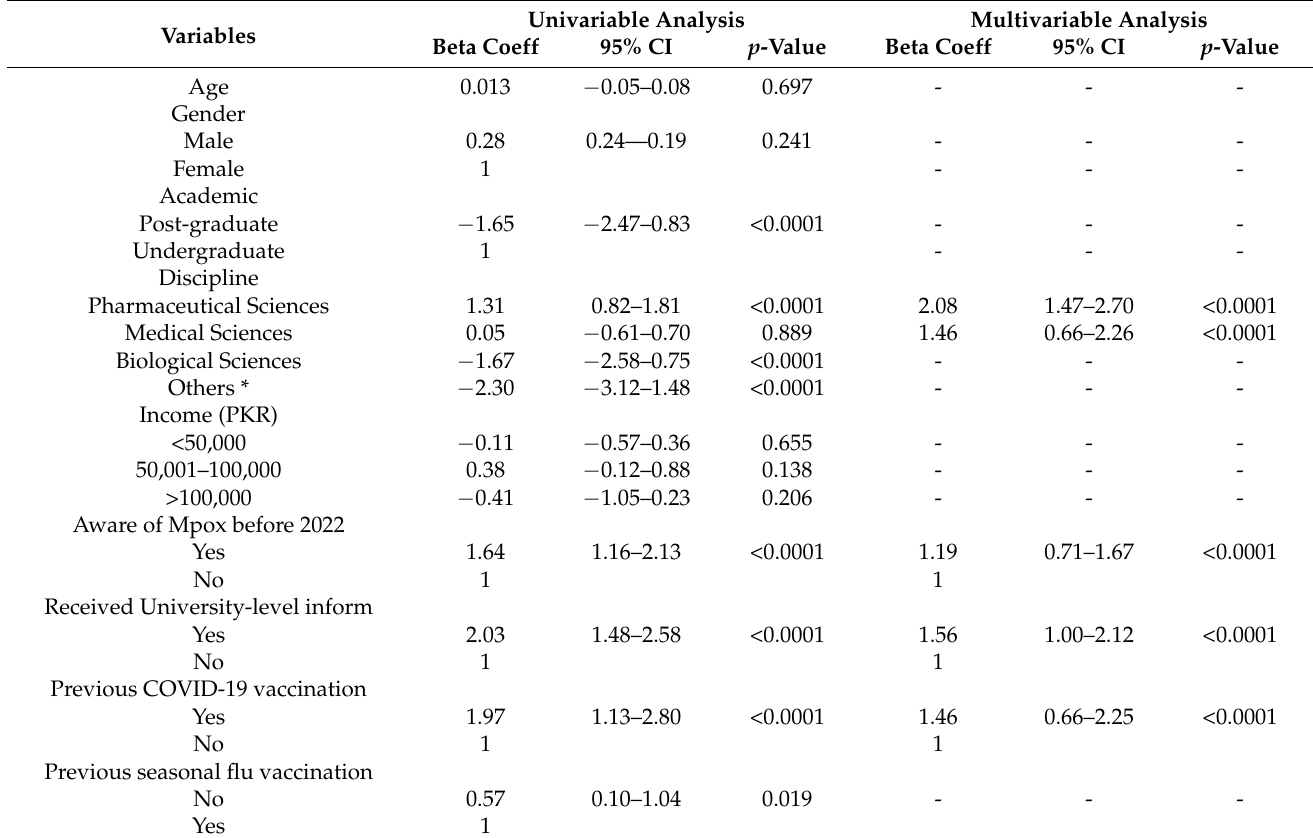
Table 5. Factors associated with knowledge of Mpox using linear